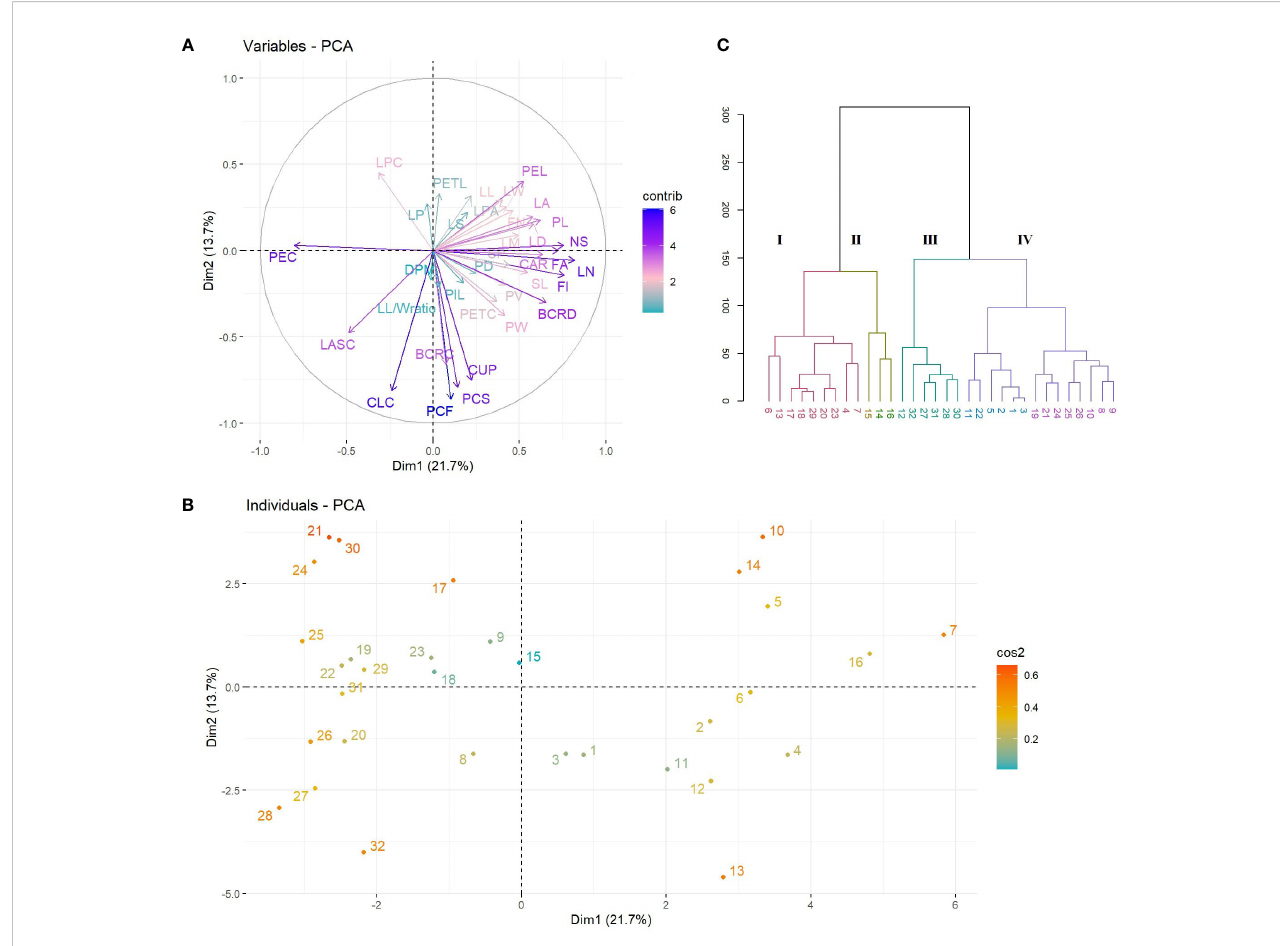
FIGURE 2 PCA plots of variables (A) and species (B) . The fi rst two dimensions accounted for 35% of full variance. HCA of Cyclamen genotypes based on morphological data (Euclidean distance, r=0.73); each color represents a different